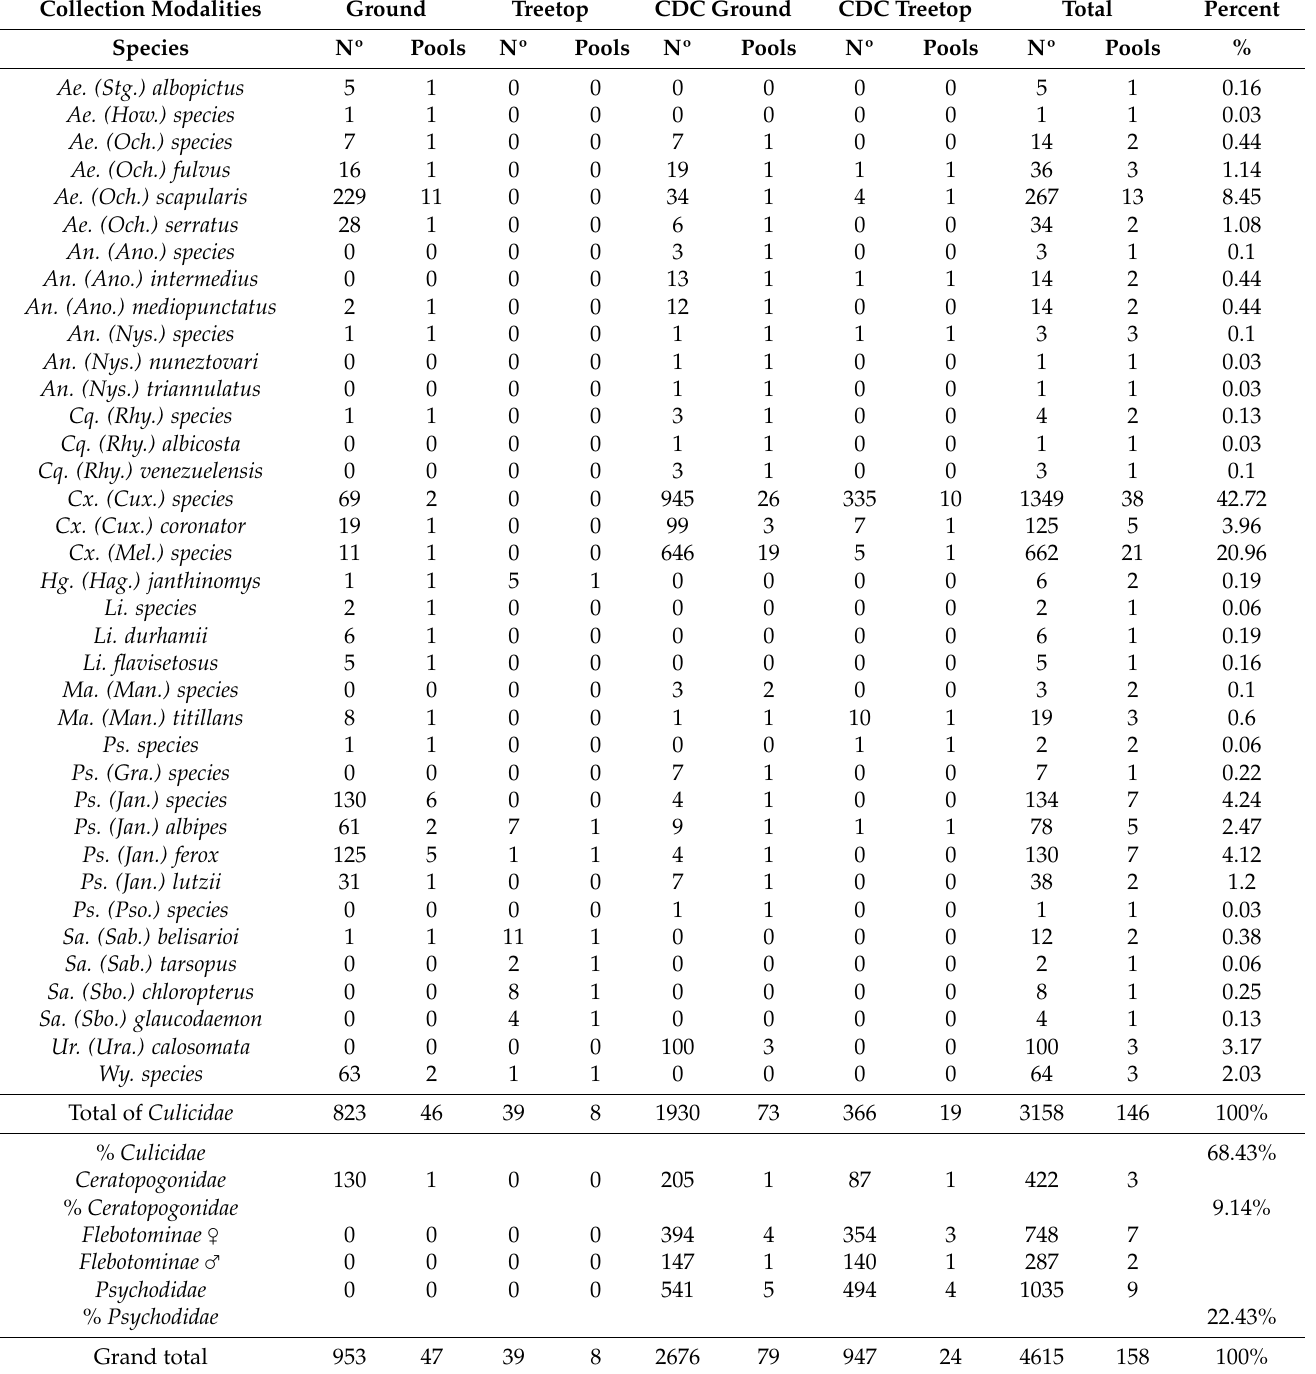
Table 2. Distribution of species collected from human attraction and CDC techniques, at Brejeira Farm, Can ã a dos Caraj á s, March 2017.